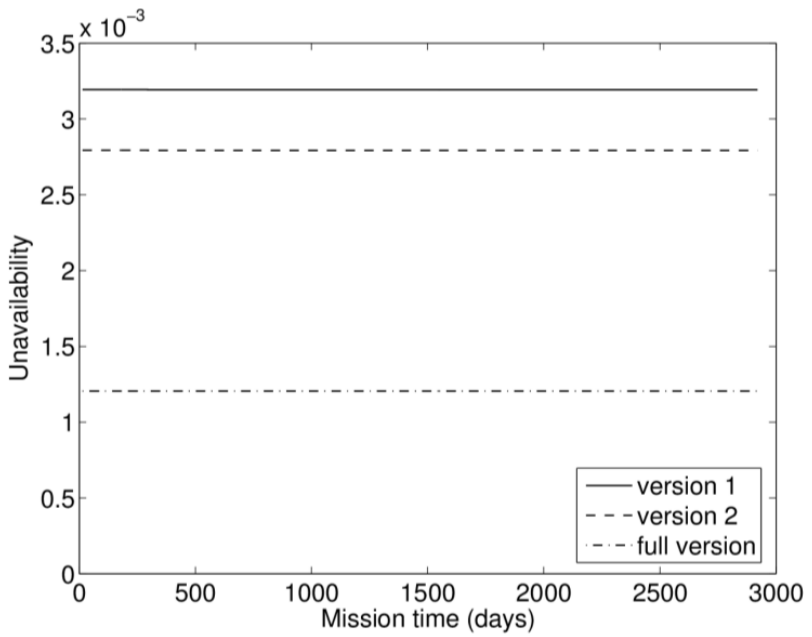
Figure 6. Comparison of unavailability evolutions for all system versions with TP = TP mid.